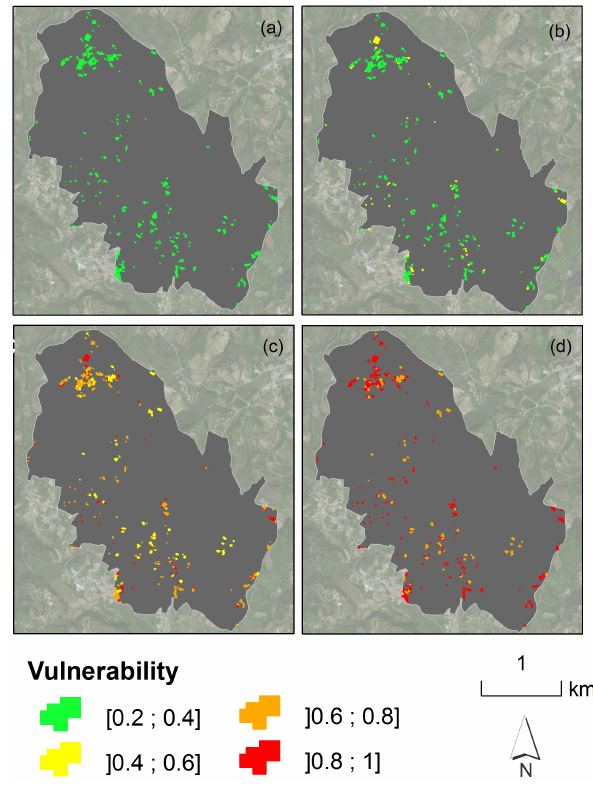
Figure 10. Vulnerability of buildings inventoried in the fieldwork area, located on a landslide foot with an affected material height of (a) 0.5m, (b) 1m, (c) 3m, and (d)